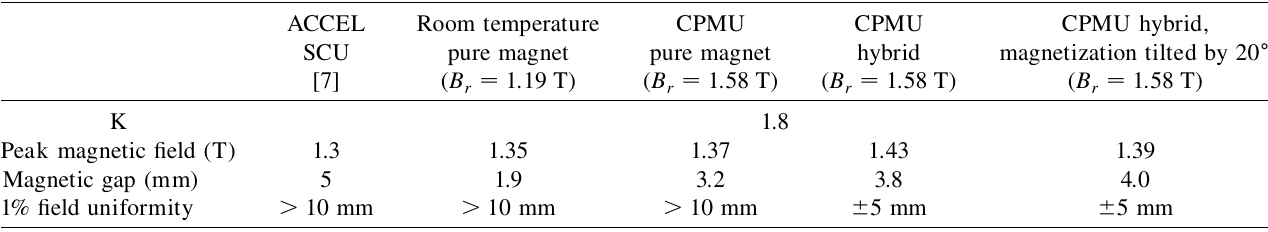
Comparison of magnetic gaps among the CPMUs, the SCU developed by ACCEL [7], and a room temperature in- (cid:3) 14 mm . K parameters of the in-vacuum undulator and CPMUs vacuum undulator under common conditions of K (cid:3) 1 : 8 and (cid:10) u are calculated according to Eq. (2). The magnet material of the CPMUs is 50BH operating at 148 K. ACCEL Room temperature CPMU CPMU CPMU hybrid, SCU pure magnet pure magnet hybrid magnetization tilted by 20 (cid:11)